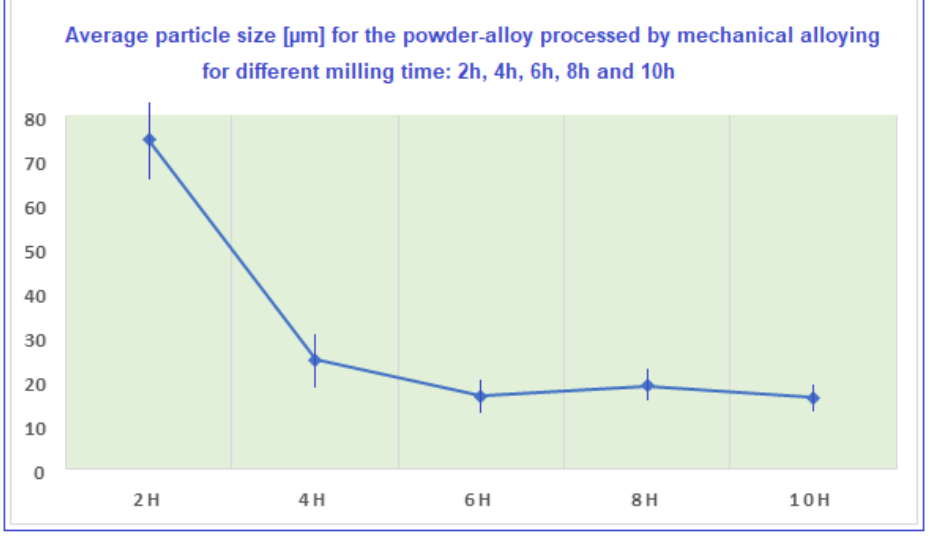
Figure 7. Average particle size ( µ m) for the powder-alloy processed by mechanical alloying for different milling time: 2 h, 4 h, 6 h, 8 h and 10 h. Table 2. Average particle size for the studied powder-alloy for varied milling